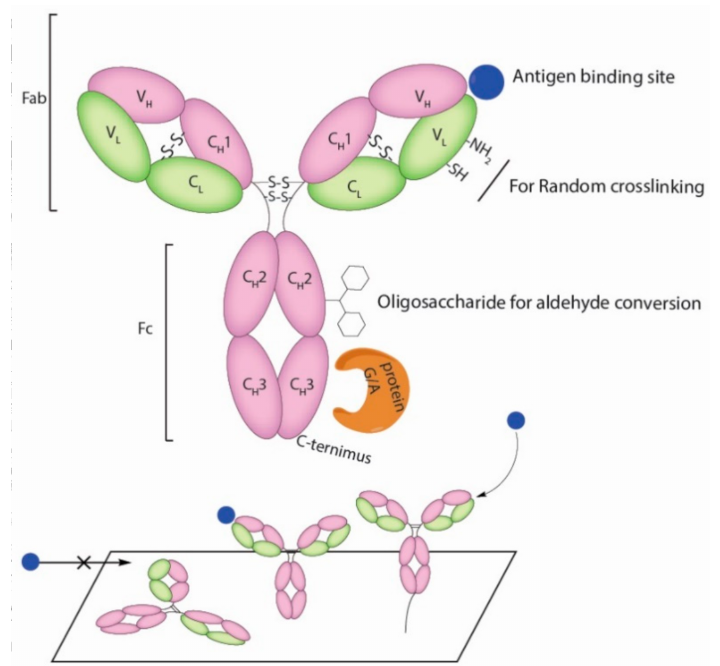
Figure 2. Functional groups on Abs used for conjugation and the result of random and oriented immobilization onto